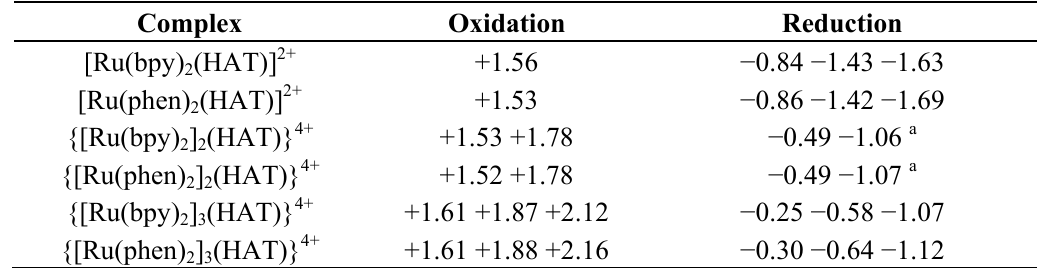
Table 6. Electrochemical data V vs. SCE for selected HAT complexes in acetonitrile